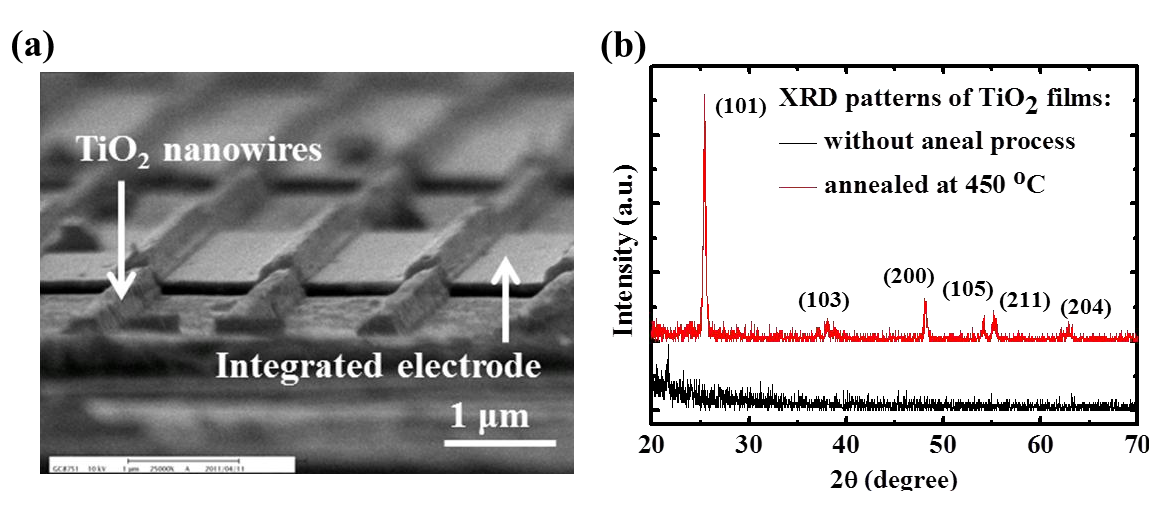
Figure 3. ( a ) SEM image of TiO with 450 °C annealing for 1 h and without the annealing